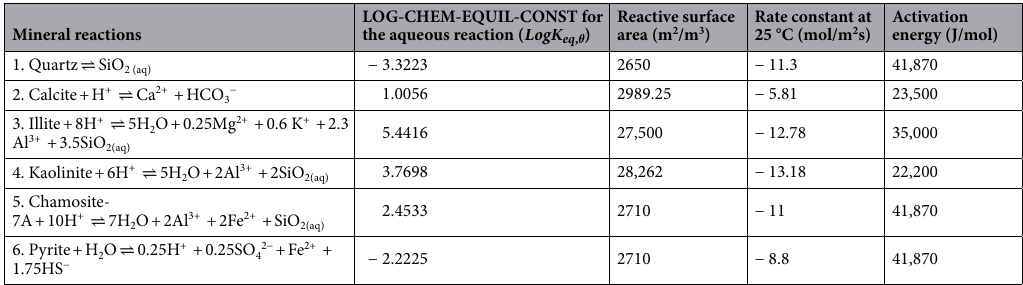
Table 3. Mineral reactions and reaction parameters.